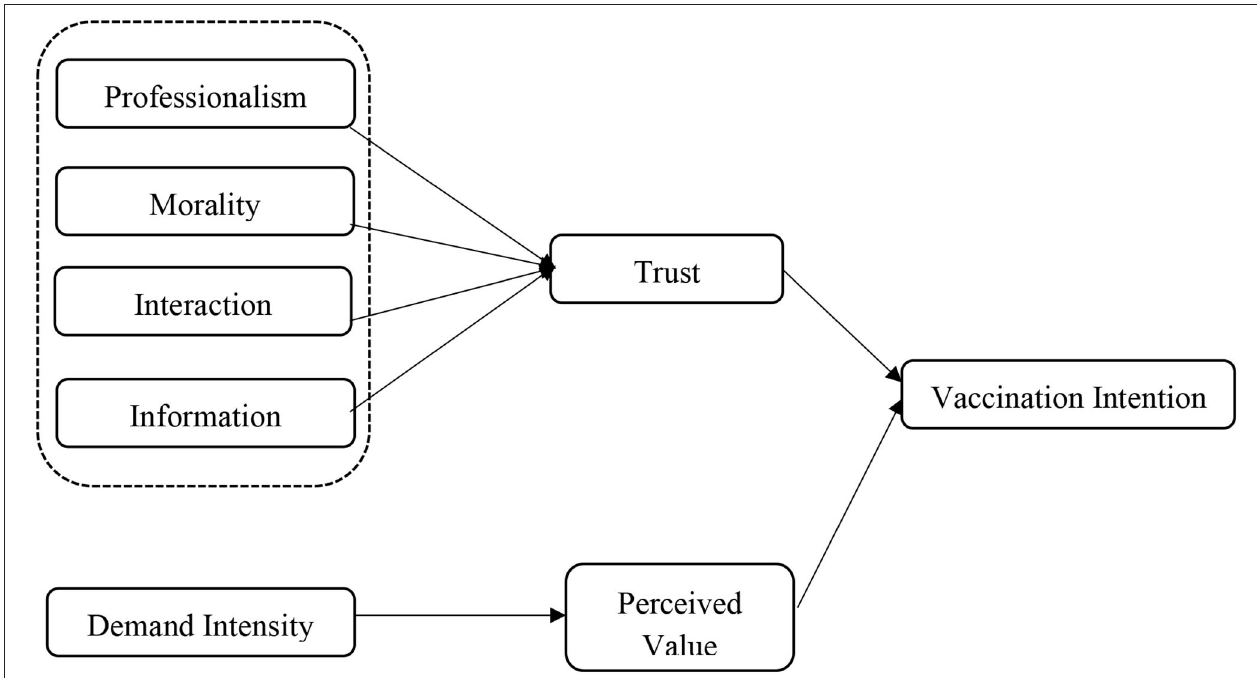
FIGURE 1 | Concept